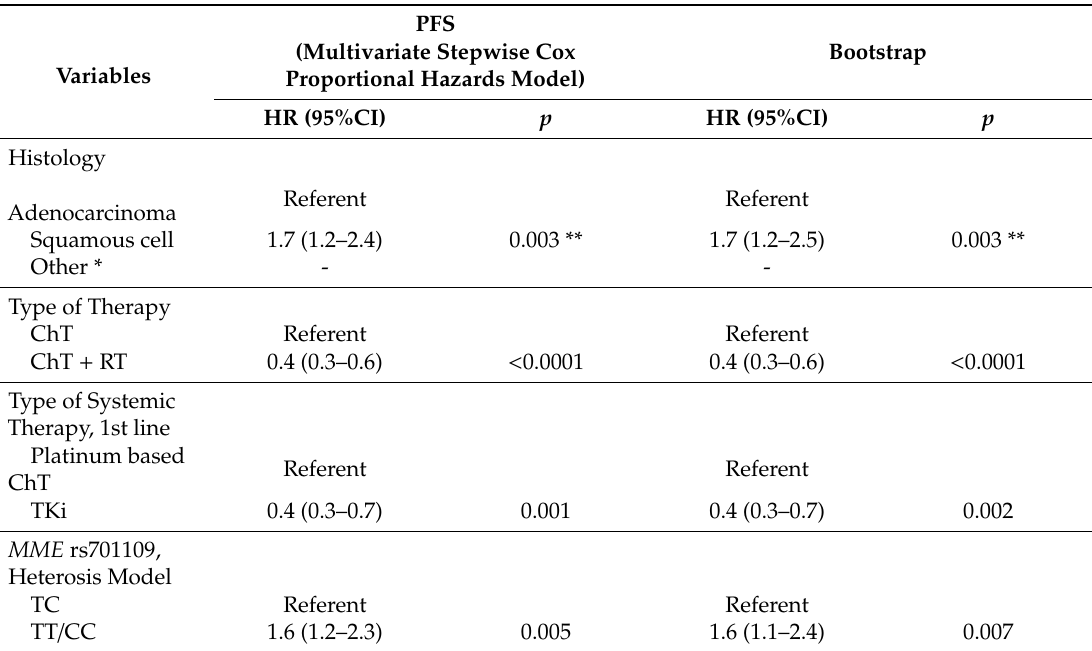
Table 4. Multivariate analysis of relevant variables for disease progression using stepwise Cox regression, followed by Bootstrap analysis with 1000 iterations from validation set ( n =